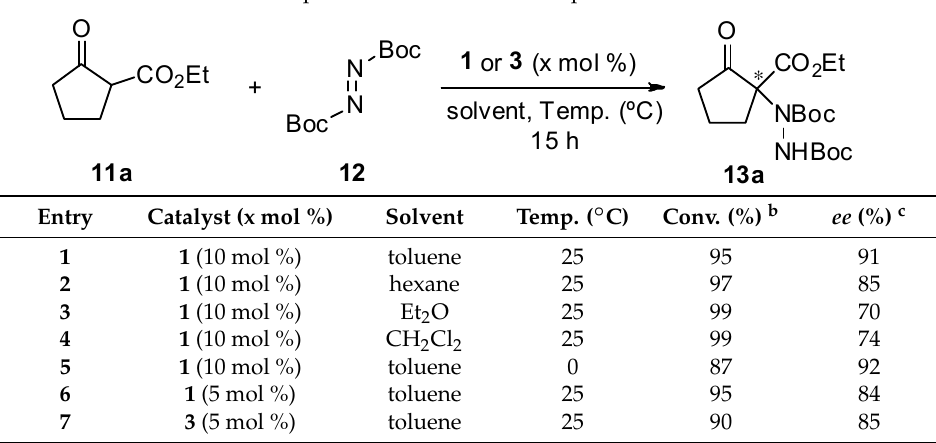
Table 2. Optimization of the reaction parameters. a